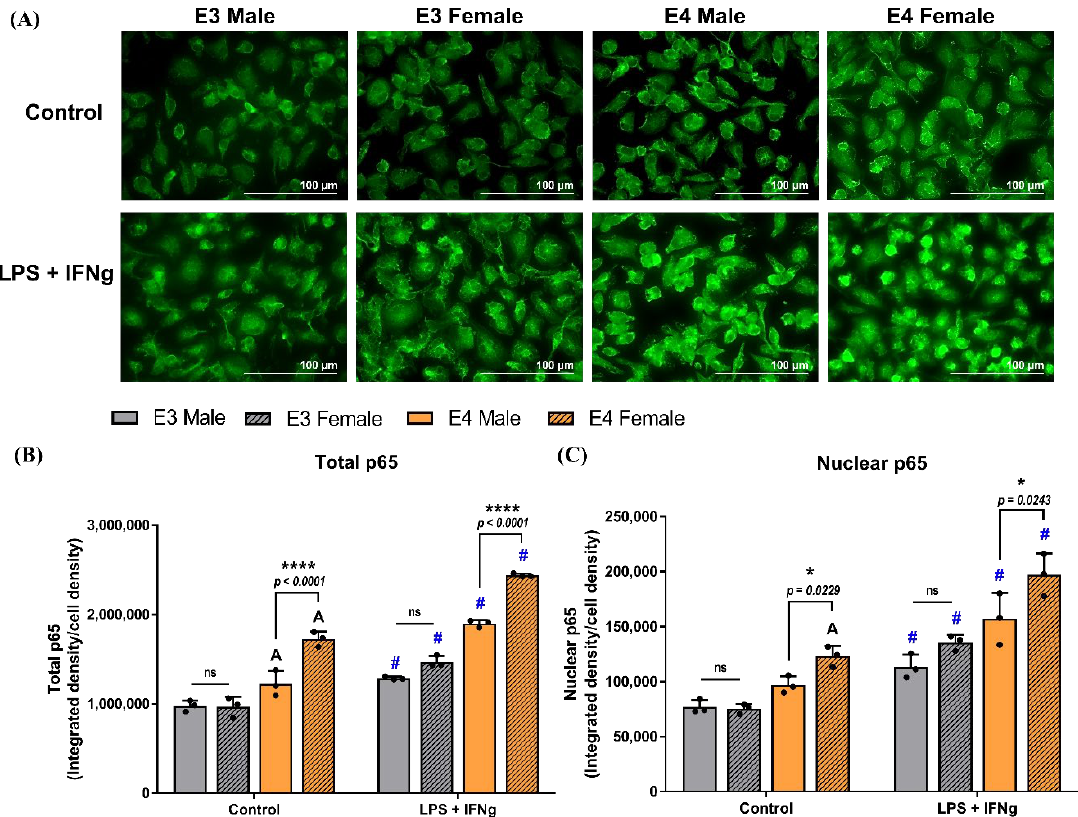
Figure 8. APOE genotype and sex-dependent inflammation are mediated through p65 activation: ( A ) representative images for immunocytochemistry of p65 in control and LPS + IFNg treated APOE3 and APOE4, male and female PMG (scale bar = 100 μm). ( B ) Quantification of total p65 and ( C ) quantification of nuclear p65. N = 3 isolations. Each data point denotes the average p65 integrated density/cell density for an individual isolation. A denotes a significant increase compared to the E3 male control ( p < 0.05). # denotes a significant increase compared to the respective genotype and sex control ( p < 0.05). Data are represented as the mean ± standard deviation. * and **** indicate statistical significance for the comparison and denote p < 0.05 and 0.0001, respectively. ns = not statistically significant ( p > 0.05).